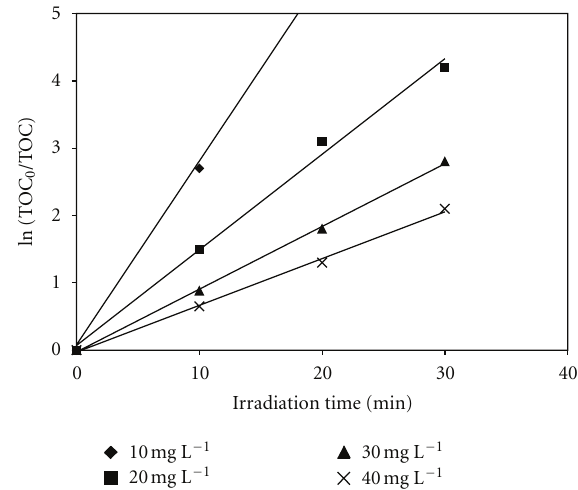
Figure 11: Determination of the pseudo-first-order kinetic rate constants, k ap .